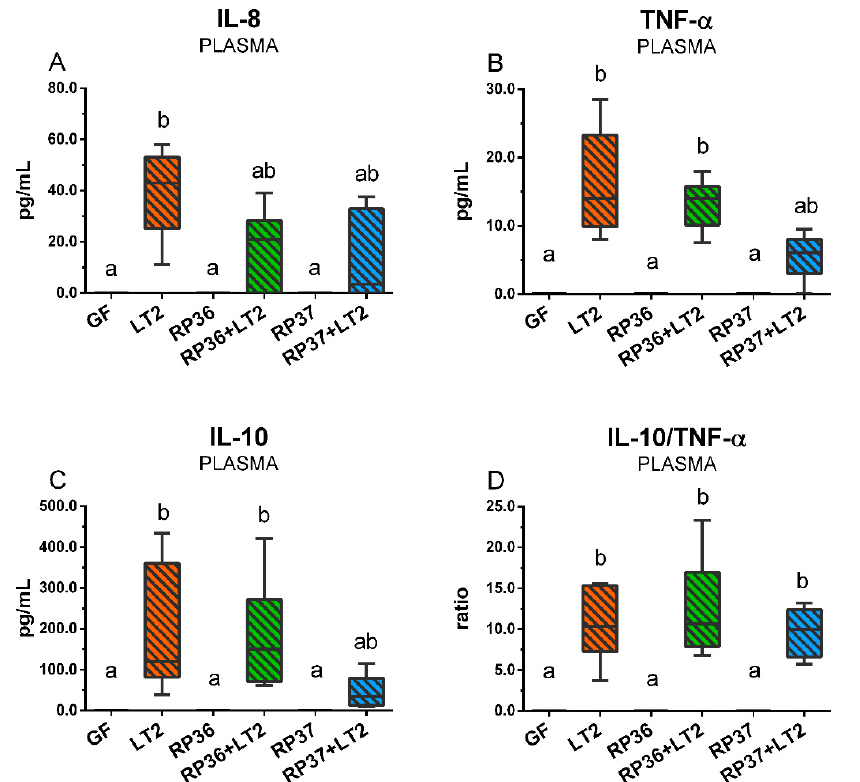
Figure 8. Plasmatic levels of IL-8 ( A ), TNF- α ( B ), IL-10 ( C ), and ratio IL-10 / TNF- α ( D ) in the gnotobiotic piglets: Germ-free (GF), infected with S . Typhimurium LT2 (LT2), colonized with B. boum RP36 (RP36), colonized with RP36 and infected with LT2 (RP36 + LT2), colonized with B. boum RP37 (RP37), and colonized with RP37 and infected with LT2 (RP37 + LT2). The values are presented as boxes indicating the lower and upper quartiles, the central line is the median, and the ends of the whiskers depicts the minimal and maximal values. Statistical di ff erences were calculated by the Kruskal-Wallis test with Dunn’s multiple comparison post-hoc test, and p -values < 0.05 are denoted with di ff erent letters above the columns. Six samples in each group were analyzed.